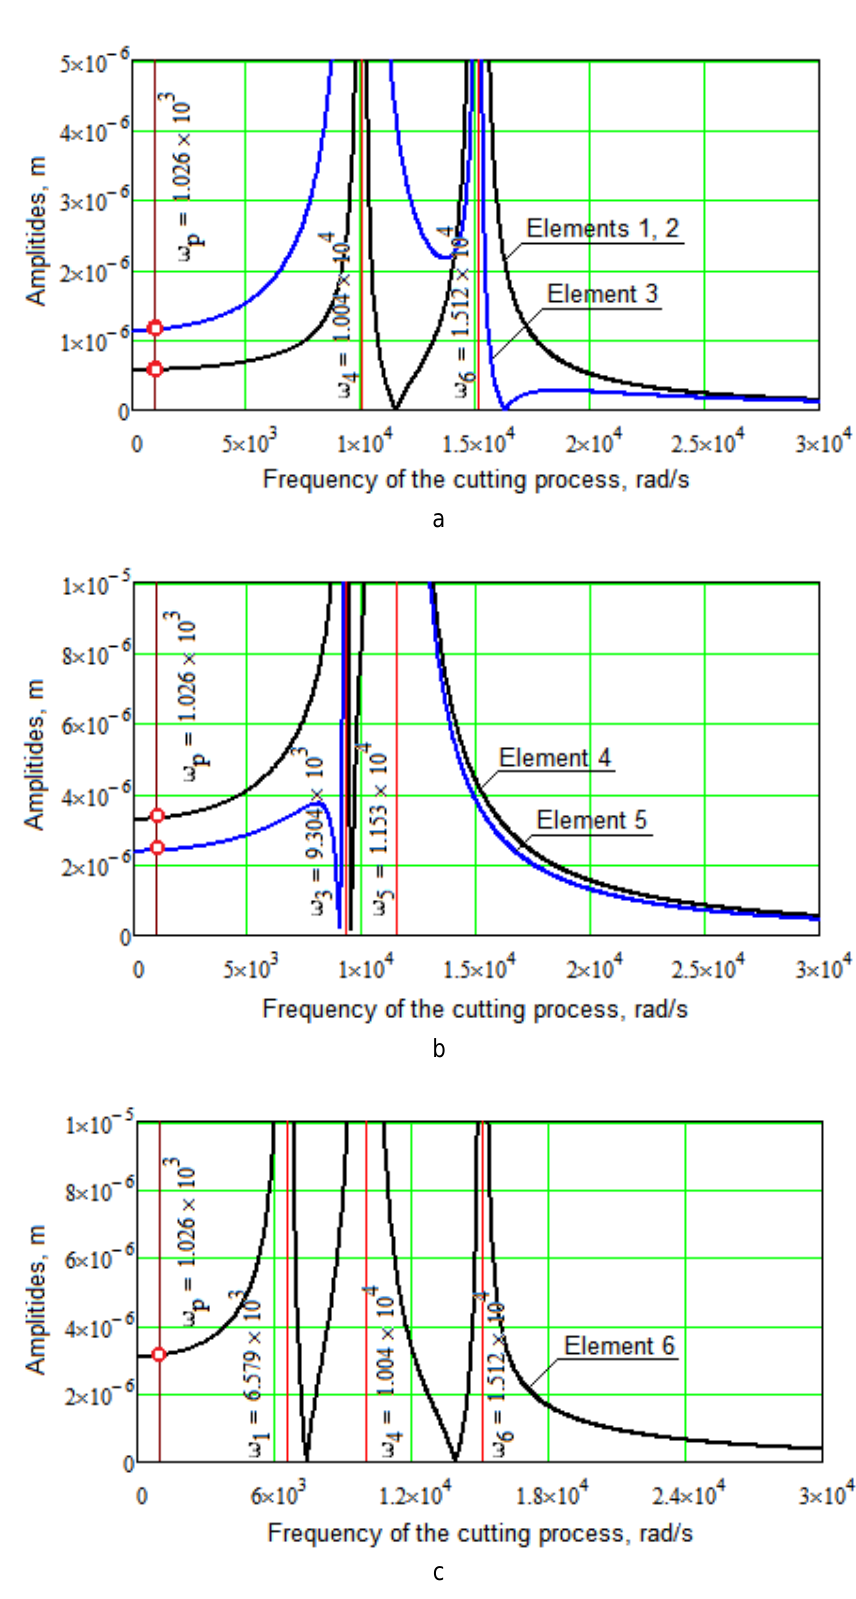
Figure 4. Amplitude-frequency response characteristics of functional elements oscillations: a – for elements 1–3; b- for elements 4–5; c – for element